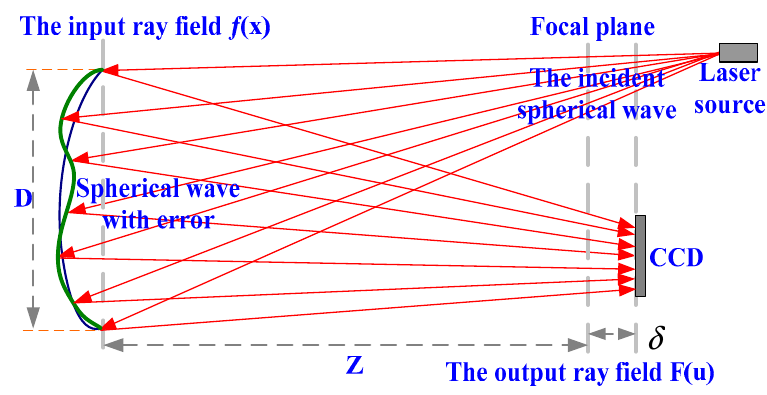
Figure 1. The principle of the Phase Retrieval system.